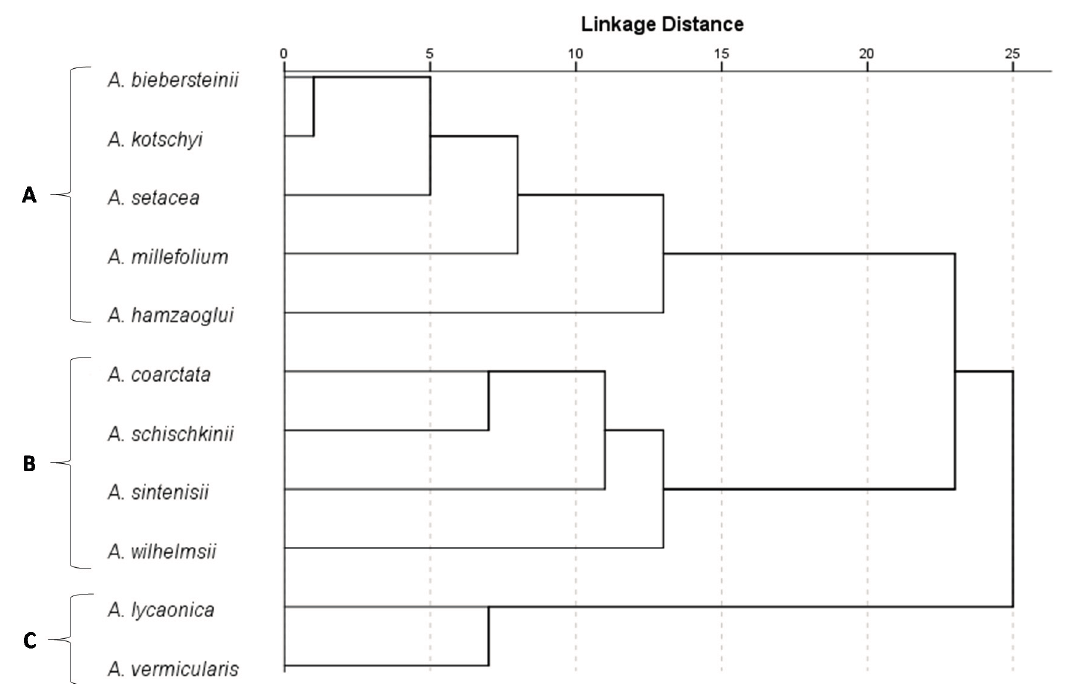
Figure 2. Dendrogram obtained by HCA based on the Euclidean distance between groups of the essential oils of eleven Achillea species growing in Turkey. A. setacea essential oil was characterized by the highest percentages of two main components in group A: α -bisabolon oxide A and hexadecanoic acid (27% and 16.4%, respectively) and a moderate content of α -bisabolol (4.8%). The essential oil of A. millefolium subsp. millefolium essential oil was characterized by the highest percentages of α -bisabolol and muurola-4,10(14)-dien-1-ol (11.7% and 6.8%, respectively) as well as its caryophyllene oxide and hexadecanoic acid content (7.7% and 4.6%, respectively) while A. hamzaoglui essential oil was characterized by the highest levels of 1,8-cineol, linalool, germacrene D (24.1%, 12.2% and 6.2%, respectively) in group